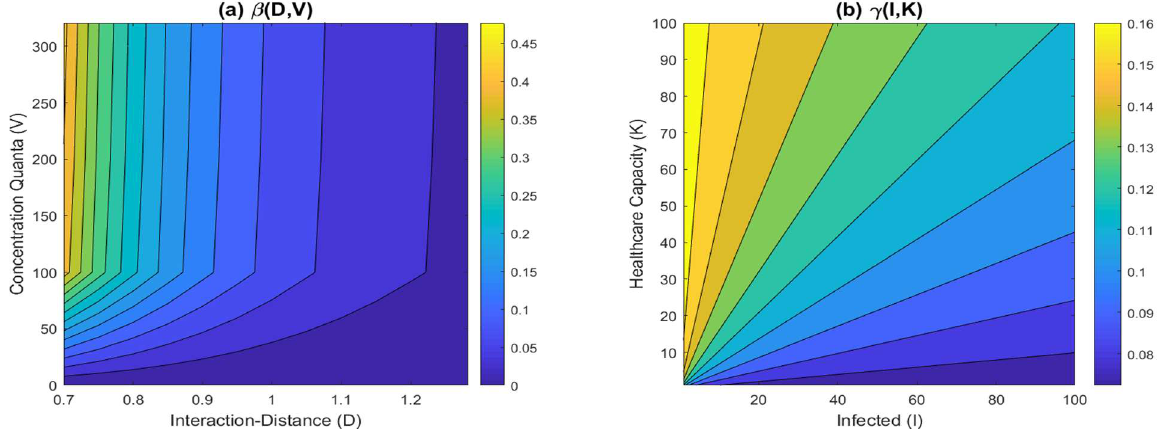
Figure 3. ( a ) Dependency of transmission rate β to D and V , by taking β ∗ = 0.444, v = 7.680, w = 0.051 and D ∗ = 0.7 m; ( b ) Effect of K and I to the rate of transmission by taking γ 1 = 1/6 (infection period of 6 days) and 𝛾 (cid:2868) = 1/14 (infection period of 14 days).